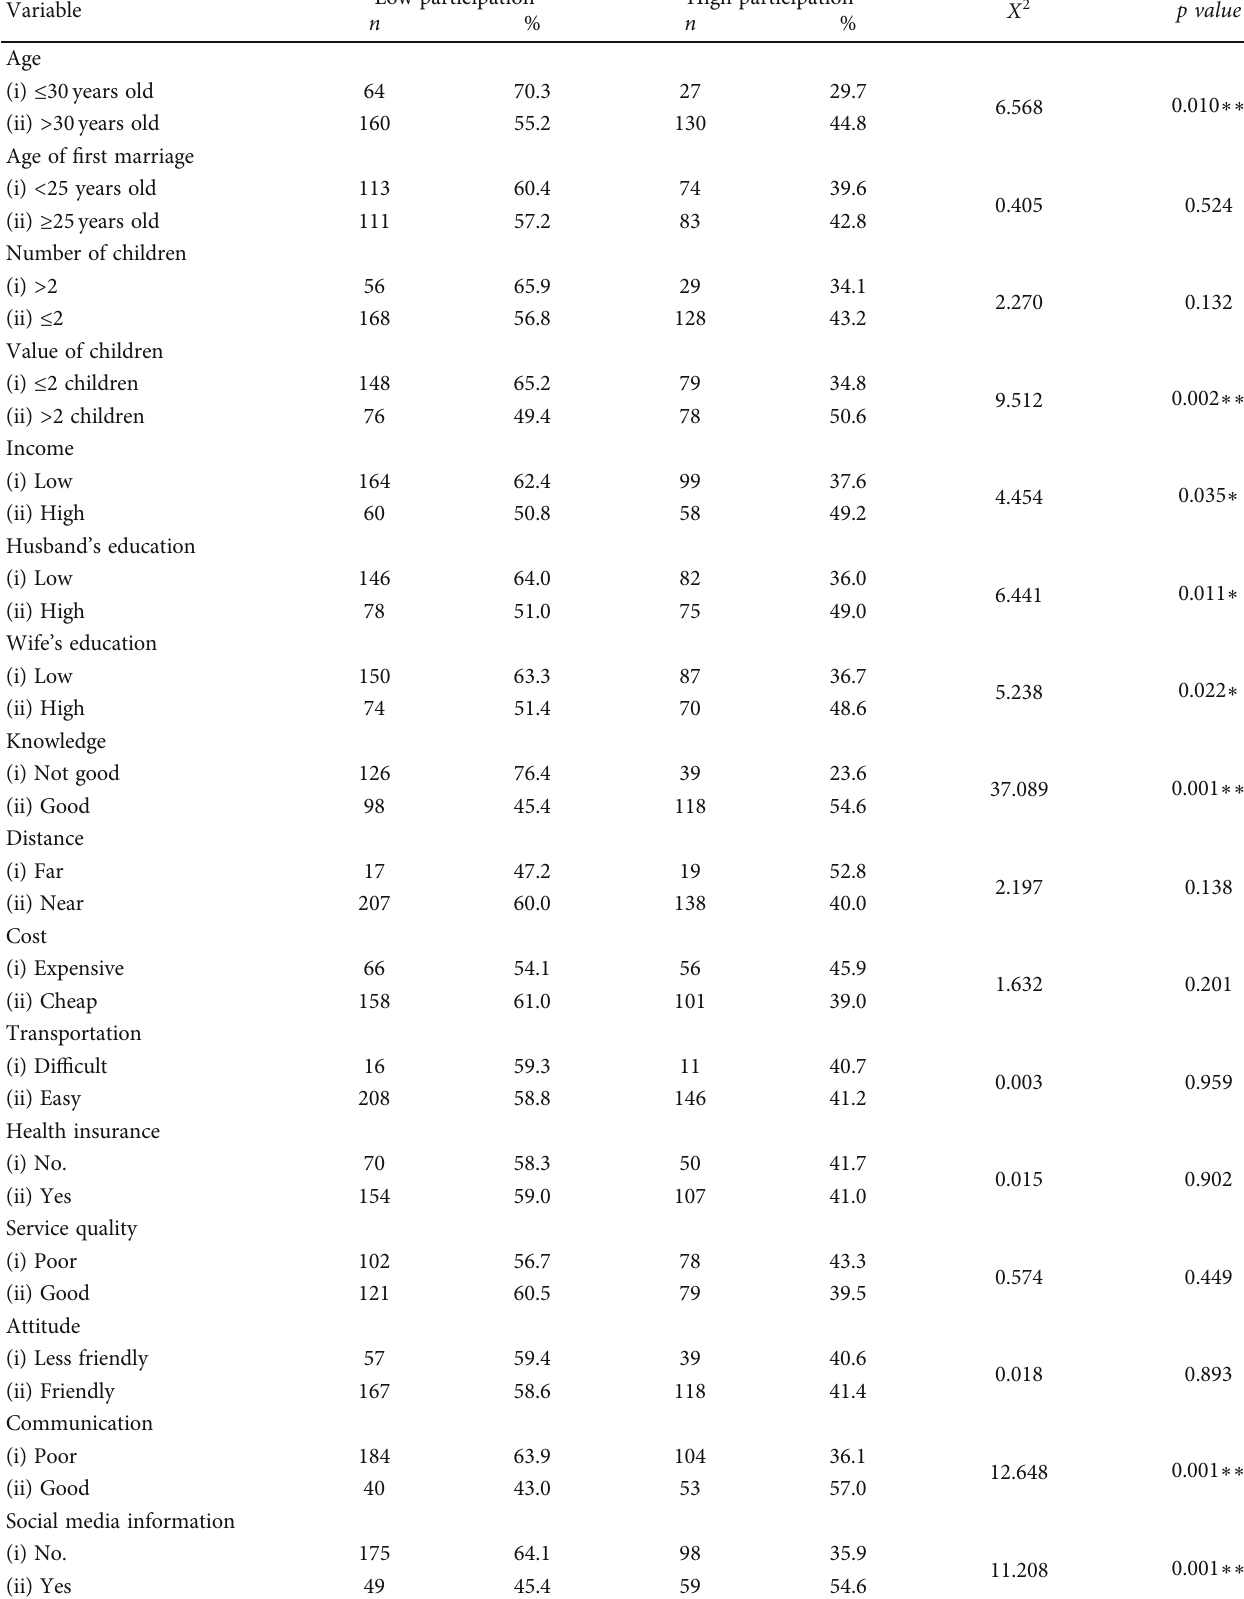
Table 3: Relation of respondent characteristics and background with male participation in antenatal